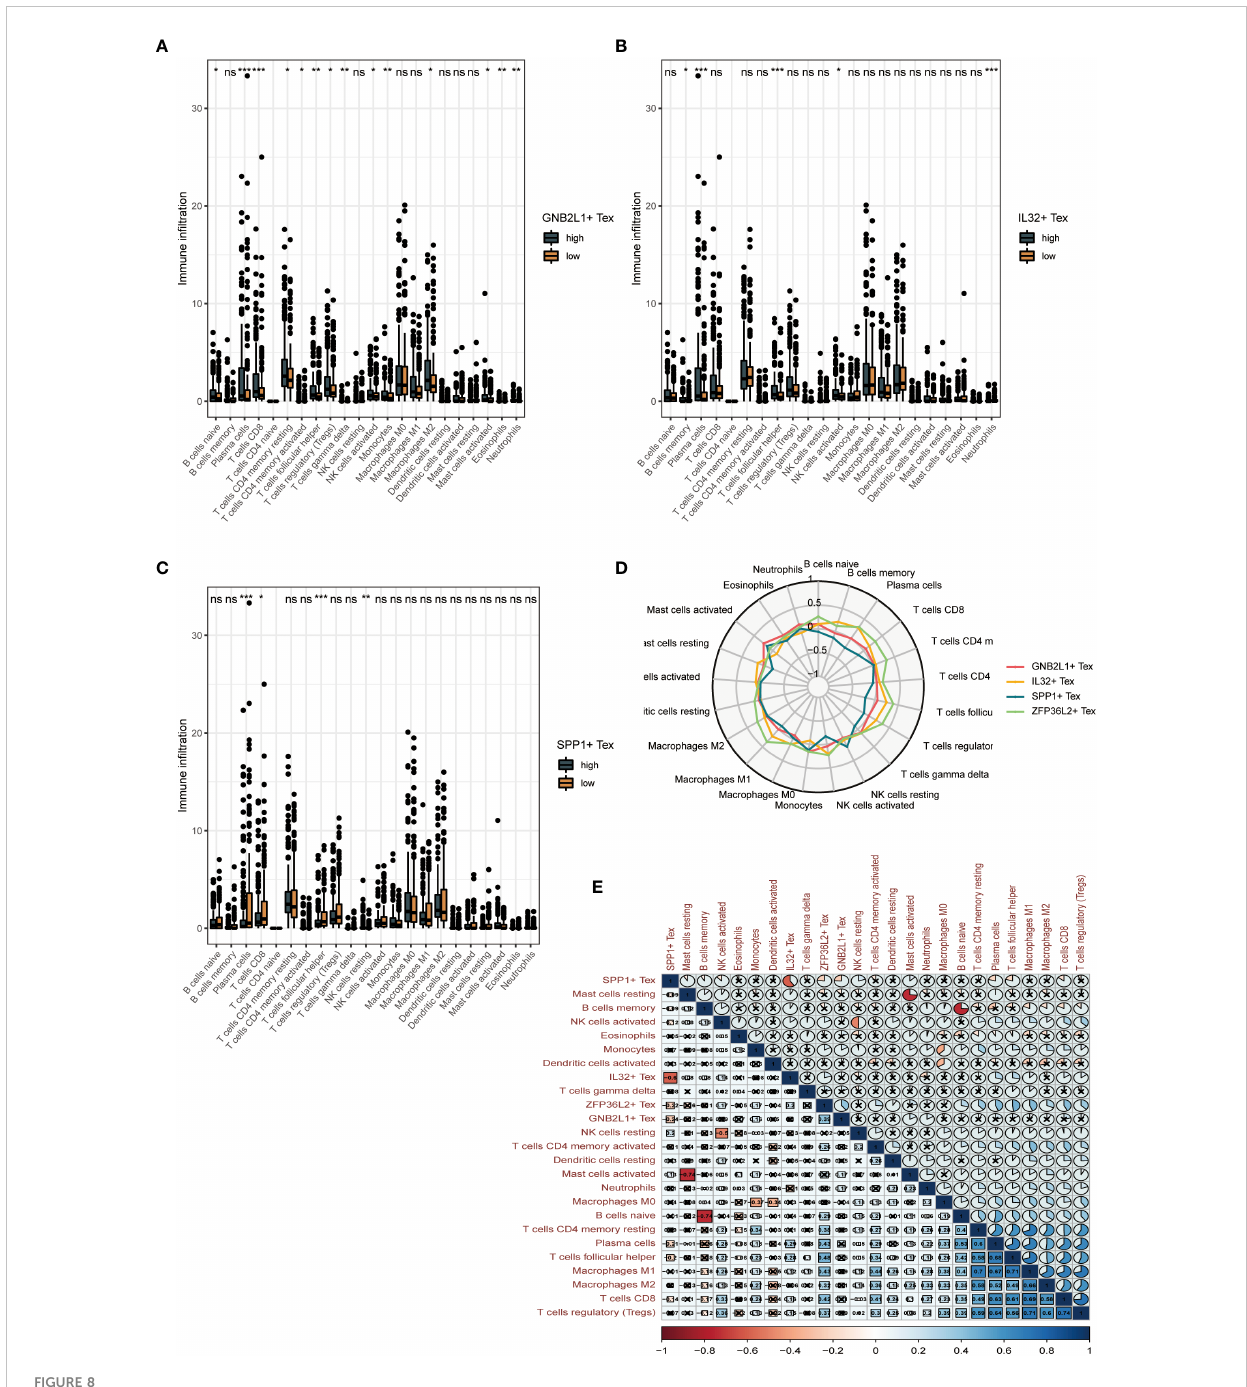
FIGURE 8 Clinical value of Tex cell clusters identi fi ed by our scRNA-seq analysis in patients from the TCGA OC cohort. (A-C) Difference in overall cellular in fi ltration between high and low groups according to median values for the 3 Tex cells. (D) Radar plots show the correlation of 4 cells with other immune cells. (E) Heat map showing correlation between all cells. * means <0.05,** means <0.01,*** means <0.001. ns means